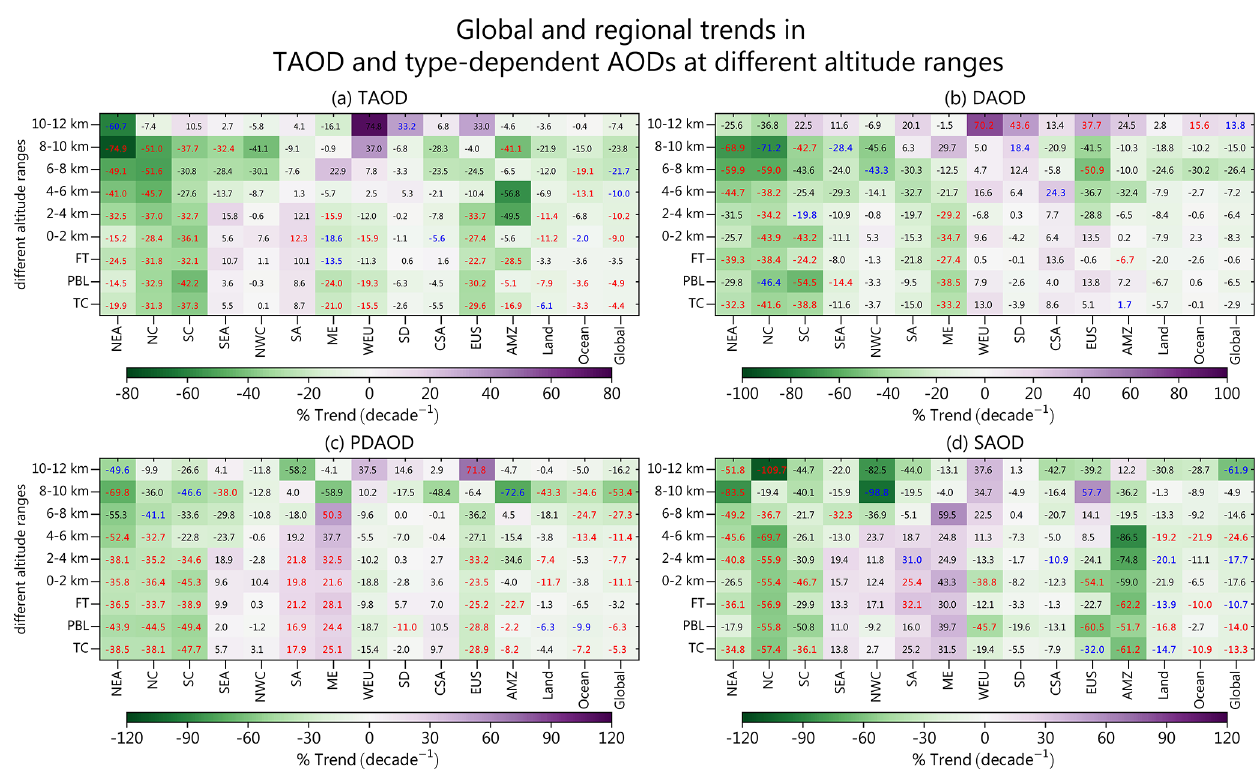
Figure 16. Global and regional percentage trends (unit: % decade − 1 ) in TAOD (a) and type-dependent AODs, including (b) DAOD, (c) PDAOD, and (d) SAOD at different altitude ranges, during the period 2007–2019. The colored squares represent the magnitude of the trend value; the numbers represent the corresponding trend value; the numbers with red and blue fonts denote that the trend values are statistically significant at the 95% and 90% significance levels, respectively. TC: total column; PBL: planetary boundary layer; FT: free